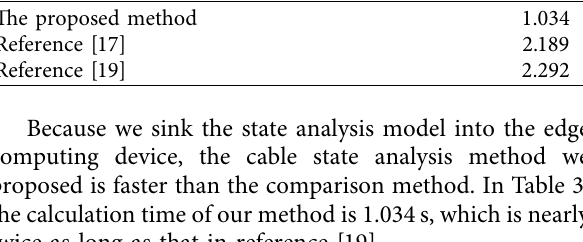
Table 3: Calculation efciency of each method.